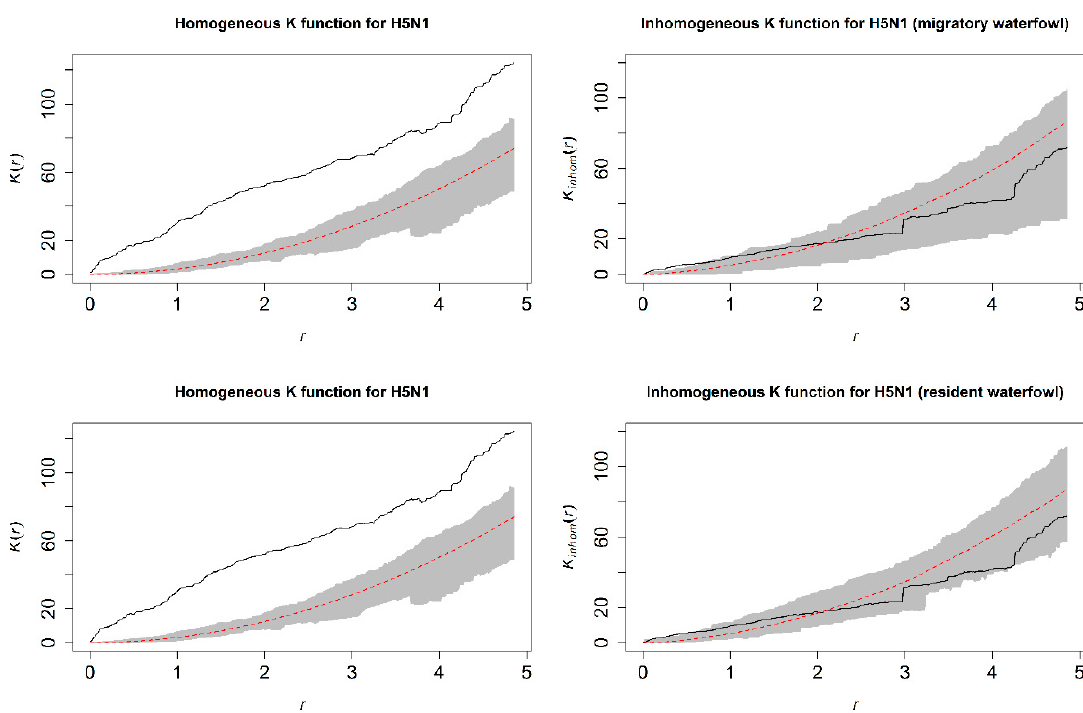
Figure 4. Homogeneous ( left panels) and inhomogeneous ( right panels) K-functions for the highly pathogenic avian influenza (HPAI) virus, subtype H5N1, outbreak point process. The homogeneous K-function is not an appropriate fit due to the spatial dependency in HPAI H5N1 outbreaks as depicted by the divergent empirical (black line) and theoretical (under spatial randomness; dashed red line with confidence bands in gray) functions. In contrast, the resident ( bottom ) and migratory ( top ) waterfowl model-based inhomogeneous K-functions show that the spatial dependency was accounted for by the model covariates (overlapping empirical and theoretical functions). The x -axes, r , represent increasing radii of subregions of the window of HPAI H5N1 outbreaks, while the y -axes represent the K-functions.